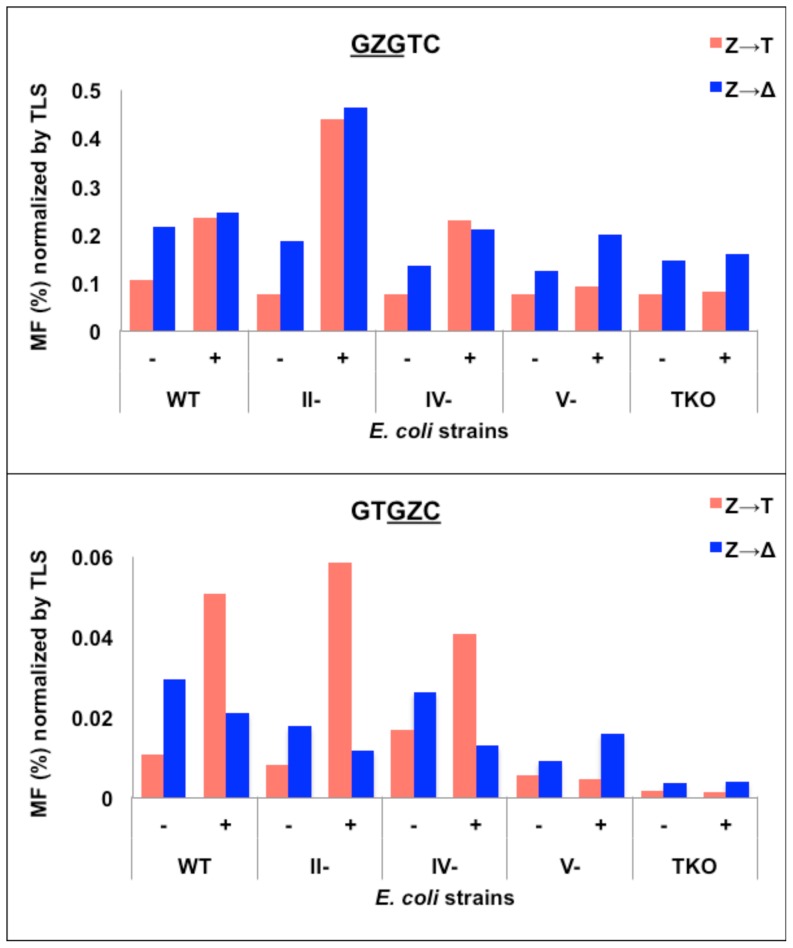
A comparison of the frequency of Z→T versus targeted Z deletion (i.e., Z→Δ) normalized by TLS (i.e., % MF multiplied with TLS frequency in hundredths) for
GZGTC and GTGZC
 constructs in wild type and pol II-, pol IV-, pol V-, and TKO E. coli strains without (−) and with (+) SOS.